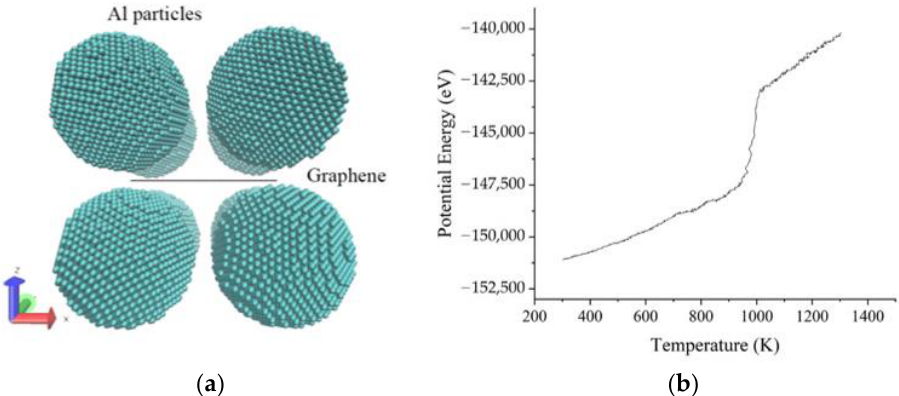
Figure 1. Details of the sintering models. ( a ) Atomistic models for building; ( b ) potential energy of pure Al bulk with respect to temperature.